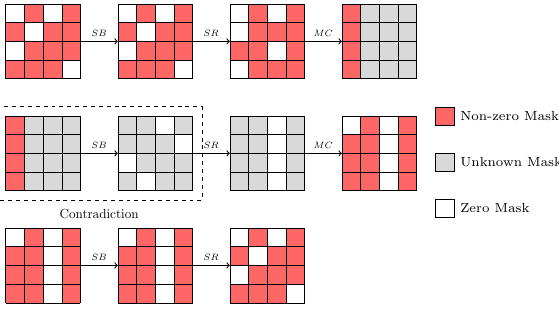
Figure 9: Zero-correlation distinguisher for AES 3 .